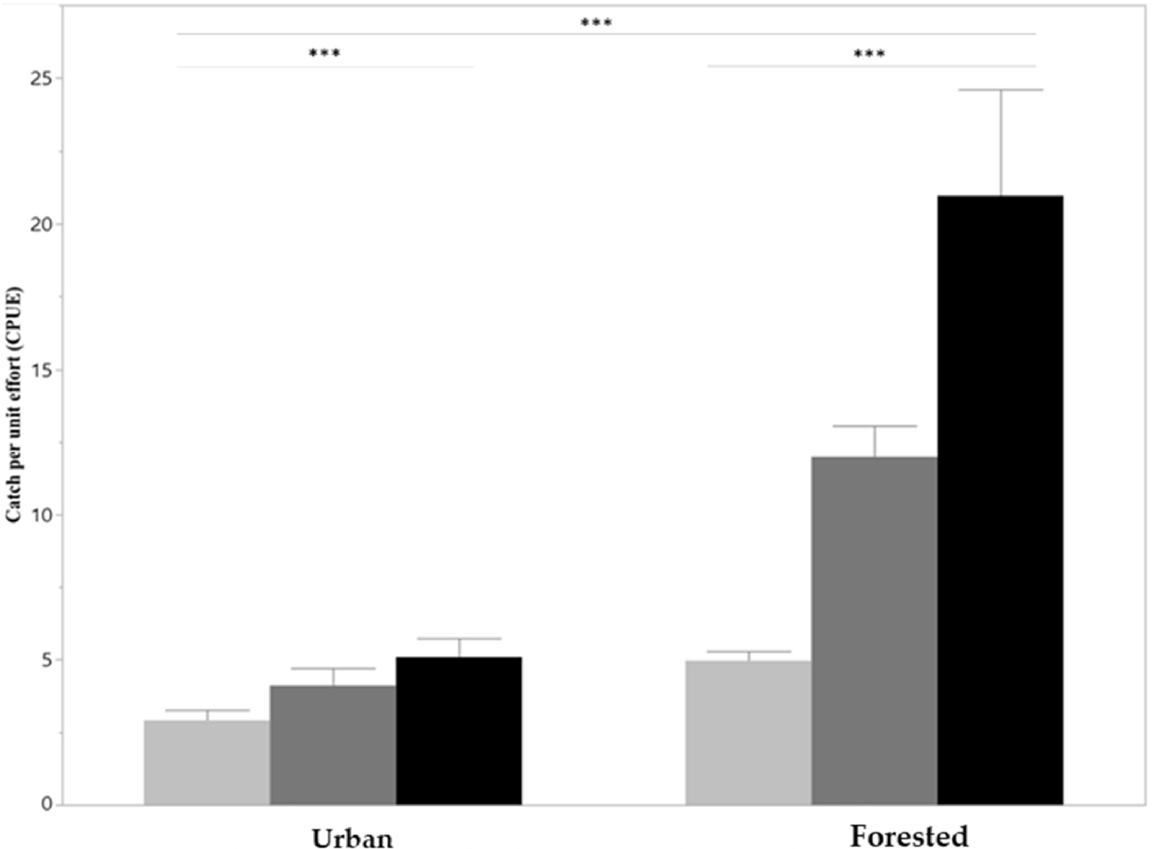
Figure 2. The mean ( ± SE) catch per unit effort (CPUE) for Xiphocaris elongata in urban (R í o Piedras) and forested (R í o Sabana) watersheds. Light grey bars represent HU (high urban), grey bars represent MU (medium urban), and black bars represent LU (low urban) reaches. The horizontal line over the bars represents the two-way ANOVA test differences *** p < 0.001.